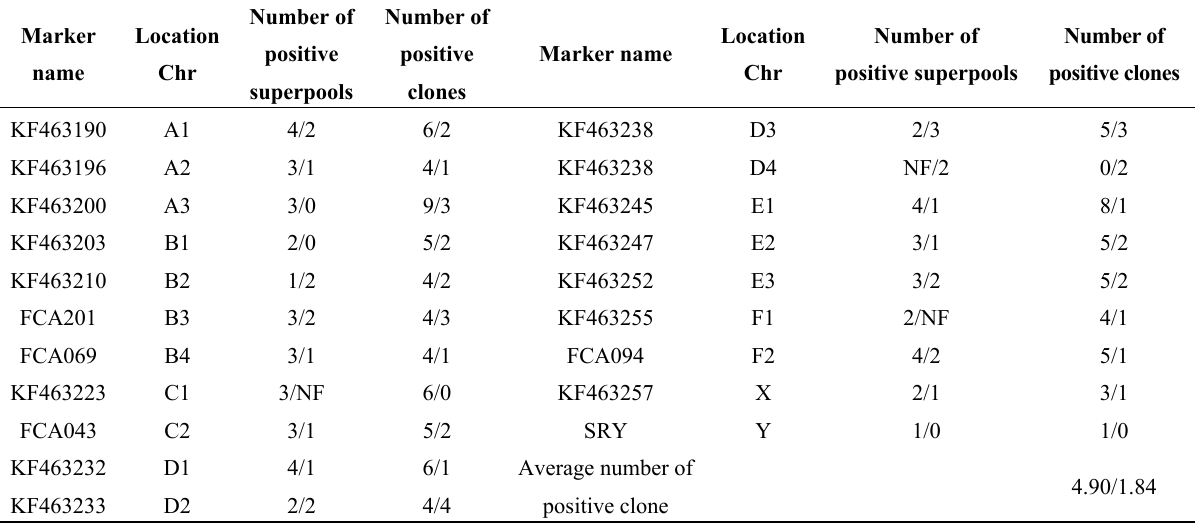
Table 2. Summary of results from screening the Siberian tiger BAC library by PCR with primers for microsatellites. The number of positive superpools for each locus (NF: not found) and the number of positive BAC clones are listed